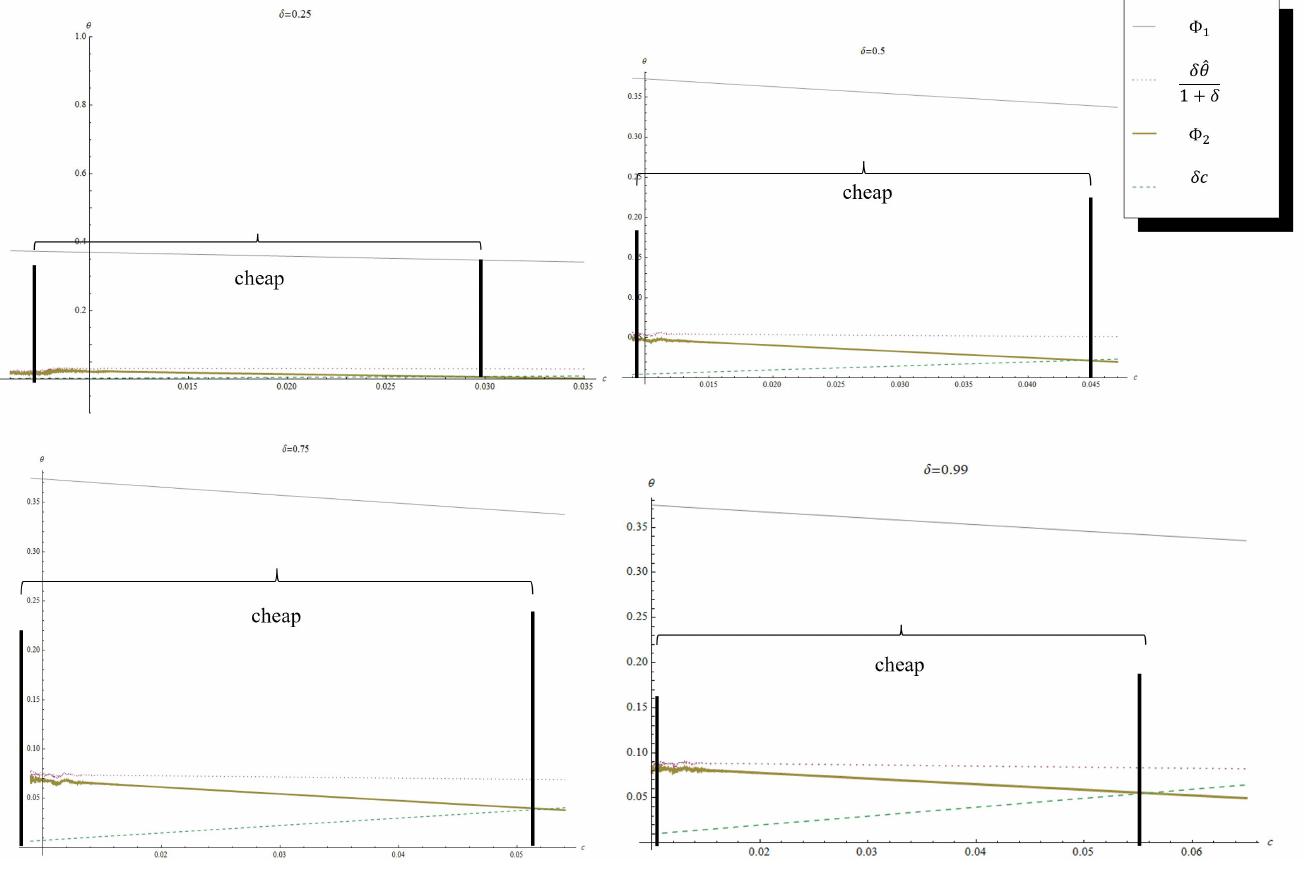
Figure 5. Existence of baseline equilibrium.